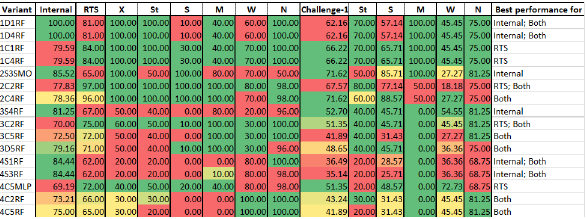
Fig 4. Percent prediction accuracy of short-listed variants of models. Color-coded scale from green to red indicates decreasing prediction accuracy. RTS and Challenge-1 sets are expanded to show the prediction accuracy for each category of sensitizers and non-sensitizers. Internal: Internal test set; RTS: Representative test set; Challenge-1: Challenge set-1; Both: Internal & RTS; X: Extreme; St: Strong; S: Sensitizer with unknown potency; M: Moderate; W: Weak; N: